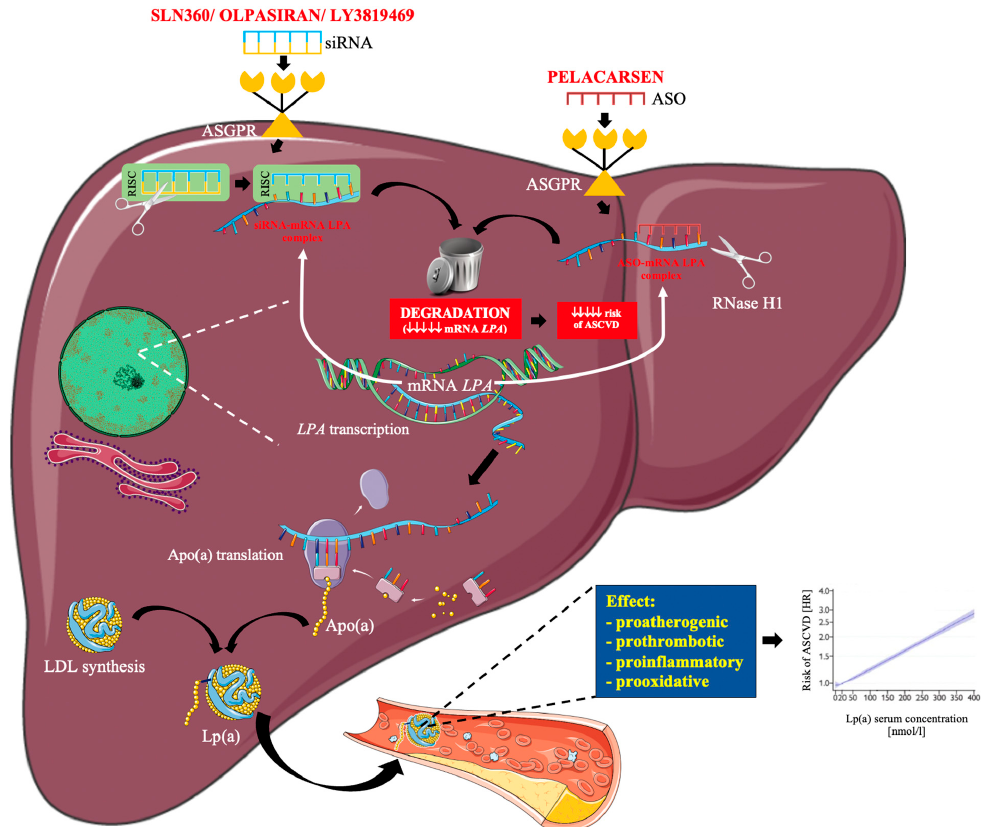
Figure 2. Mechanism of action of SLN360, olpasiran, LY3819469 and pelacarsen [11,15,48]. ASGPR—asialoglycoprotein receptor; ASO—antisense oligonucleotides; siRNA—small interfering RNA; LPA—lipoprotein (a) gene; LDL—low density lipoprotein; ASCVD—atherosclerotic cardiovascular disease; Lp(a)—lipoprotein (a); apo (a)—apolipoprotein (a); RICS—RNA-induced silencing complex. The following was used in the preparation of the figure: https://smart.servier.com (accessed on 29 October 2022;